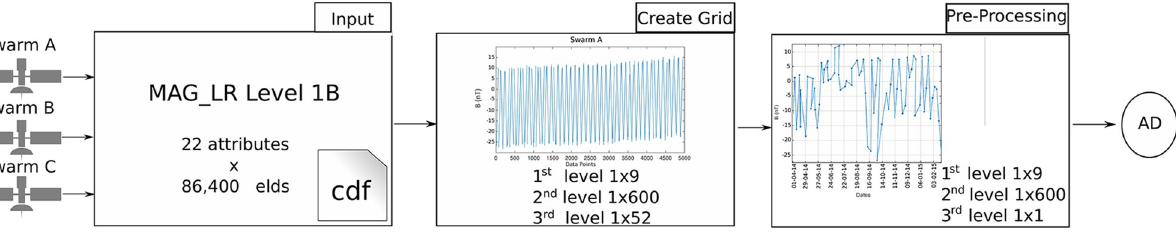
Fig 1. Data structure throughout the different stages of the